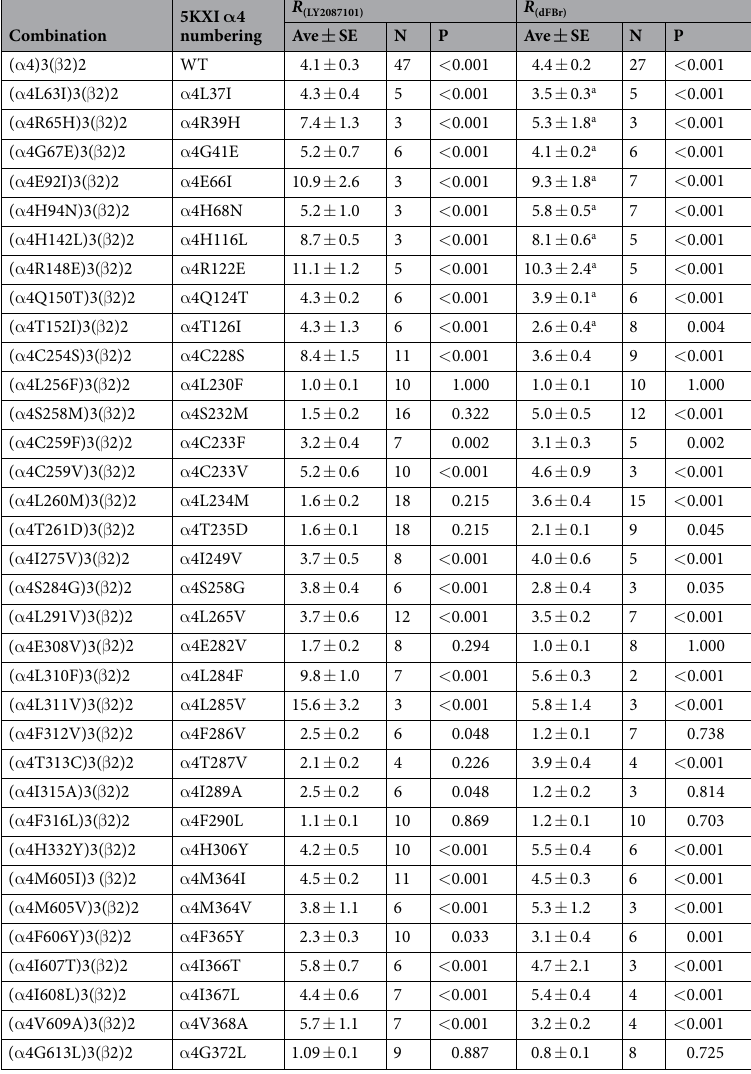
Table 1. Modulation of WT and mutants ( α 4)3( β 2)2 nAChRs by LY2087101 and dFBr. Current